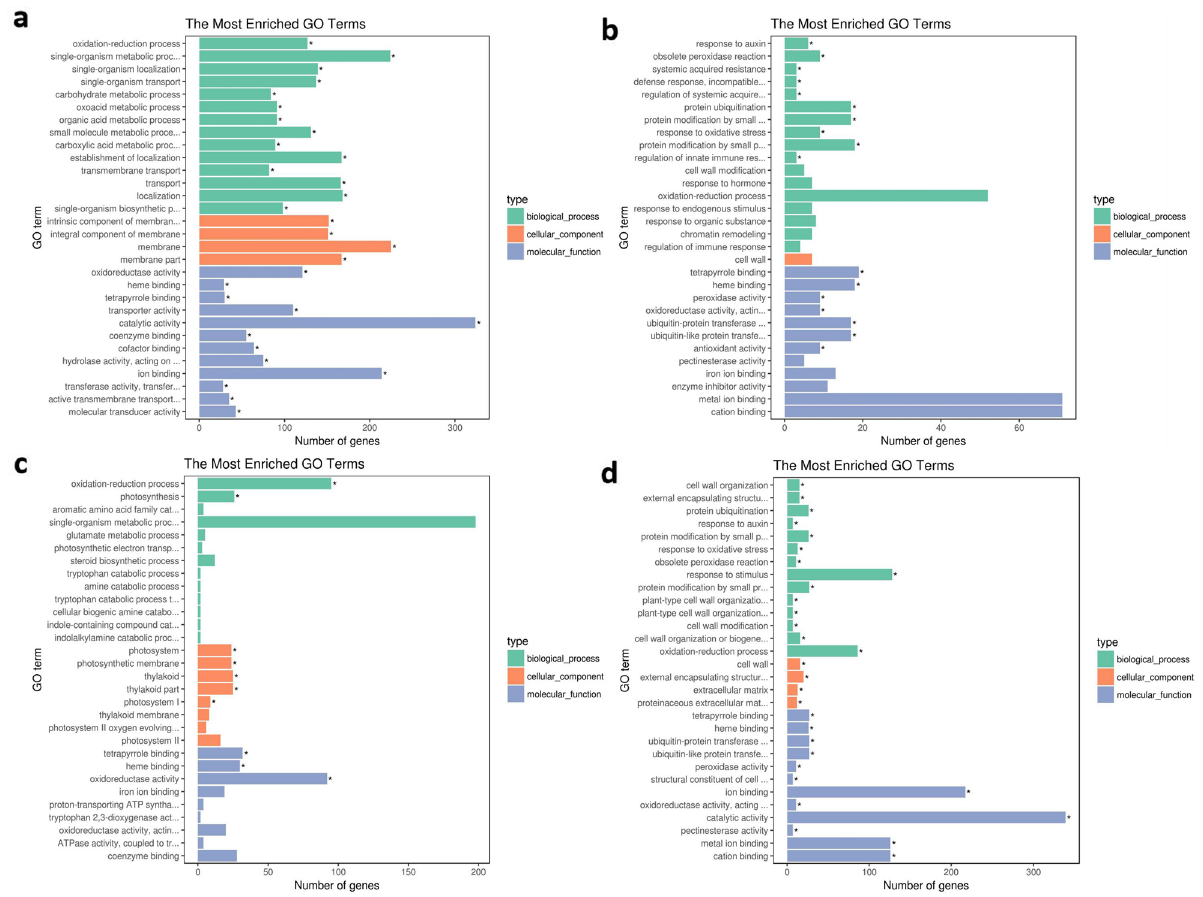
Figure 6. GO enrichment analysis of the DEGs in CK versus G5 and CK versus G10. ( a ) Down-regulated unigenes in control and 5% 1-G4 treated BS. ( b ) Up-regulated unigenes in control and 5% 1-G4 treated BS. ( c ) Down-regulated unigenes in control and 10% 1-G4 treated BS. ( d ) Up-regulated unigenes in control and 10% 1-G4 treated BS. X-axis represents the number of unigenes; Y-axis represents the GO terms names: green pillars represent biological process, orange pillars represent cellular process and blue pillars represent molecular